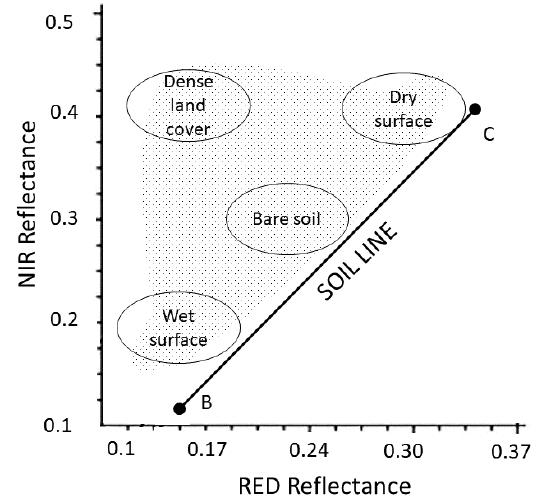
Figure 5. Near infrared versus red (NIR/R) correlation to obtain the soil line for the perpendicular drought index (PDI) calculation. Adapted from [32].